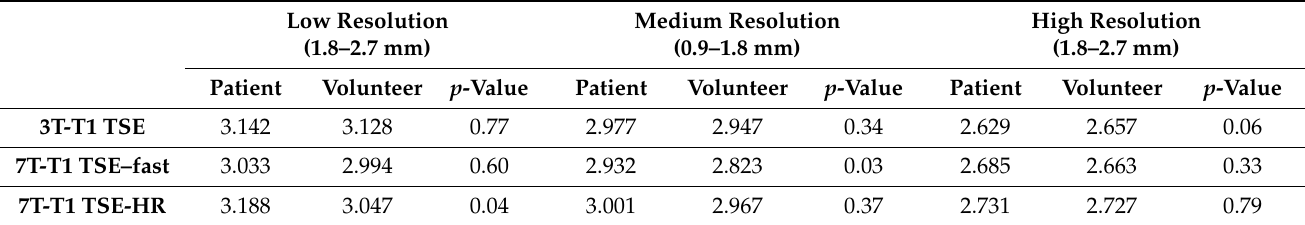
Table 2. Comparison of horizontal fractal dimensions between the patient group and volunteer group using 3T and 7T magnetic resonance imaging (MRI).